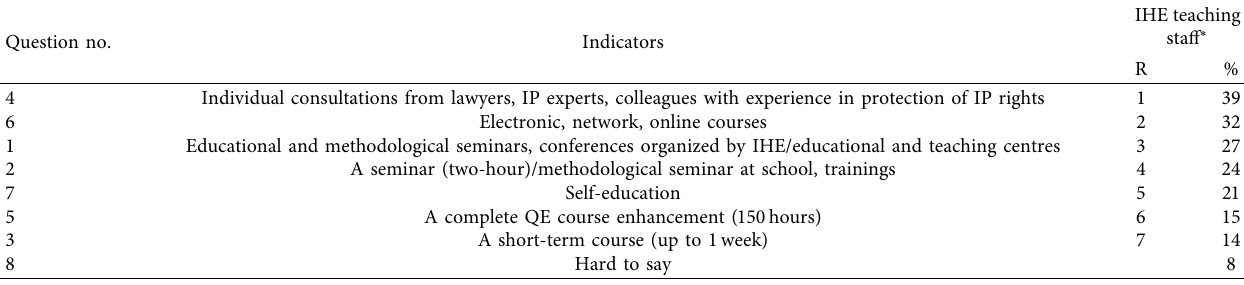
Table 8: Effective forms of enhancement of qualification and literacy in IPR protection. Question